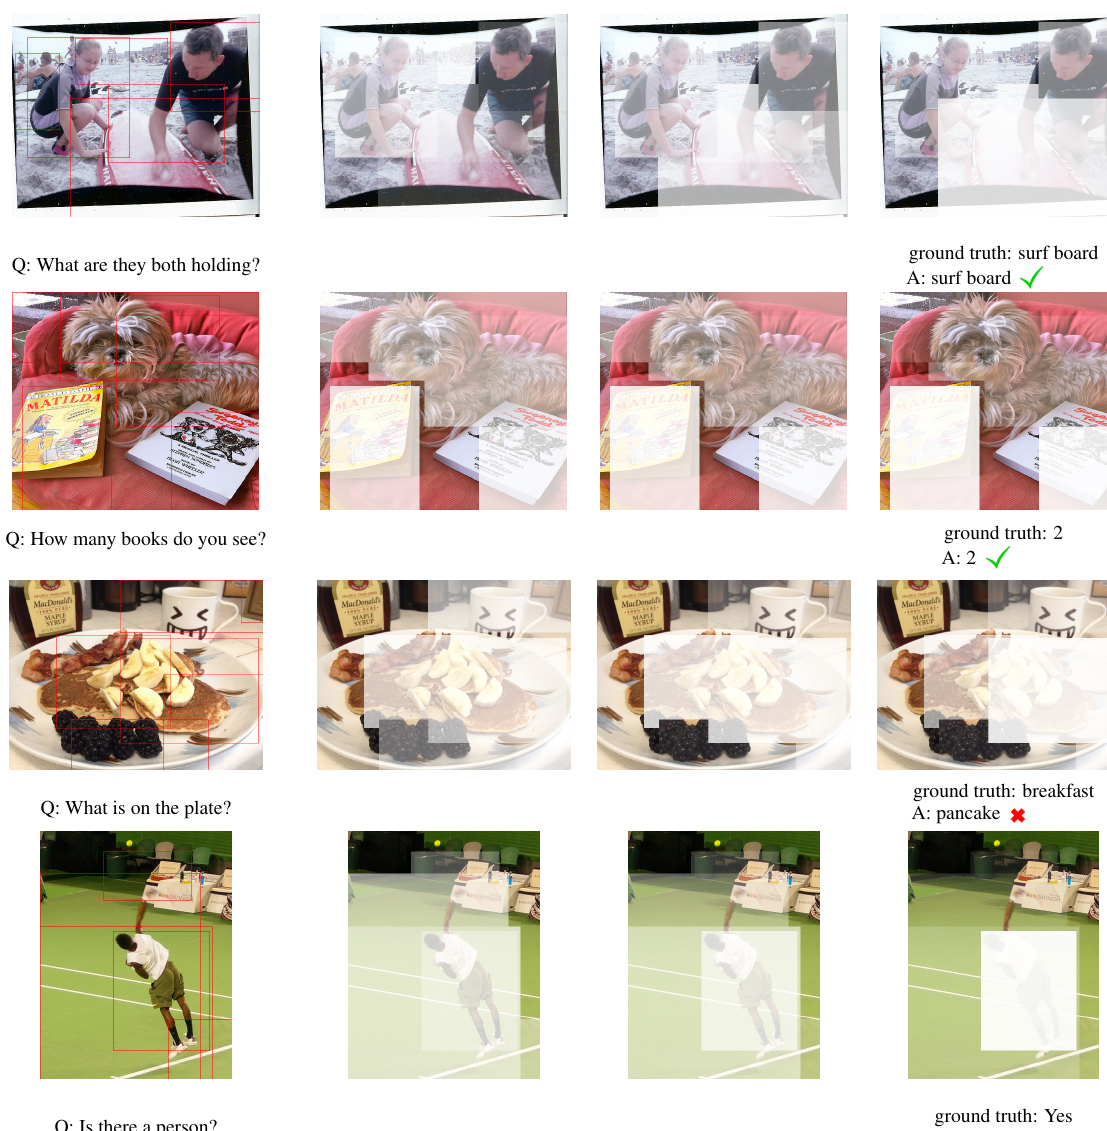
Figure 3. Visualization of the attention weights of image regions with three GFA